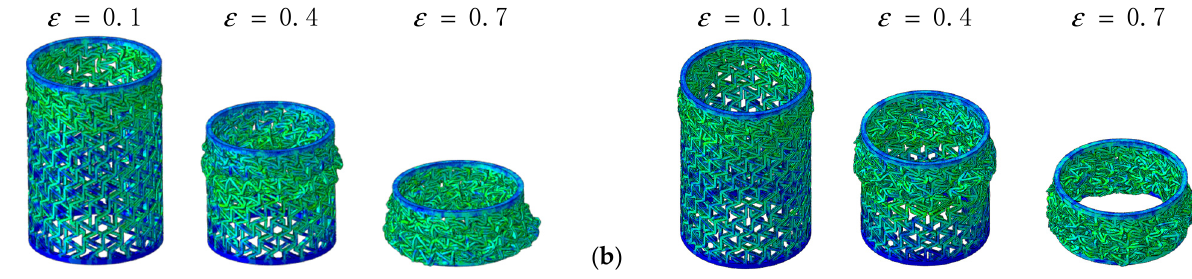
Figure 24. ( a ) The force–displacement curves of multi-layer composite RHCSs and ( b ) the SEA curves of multi-layer composite RHCSs when V = 60 m/s.